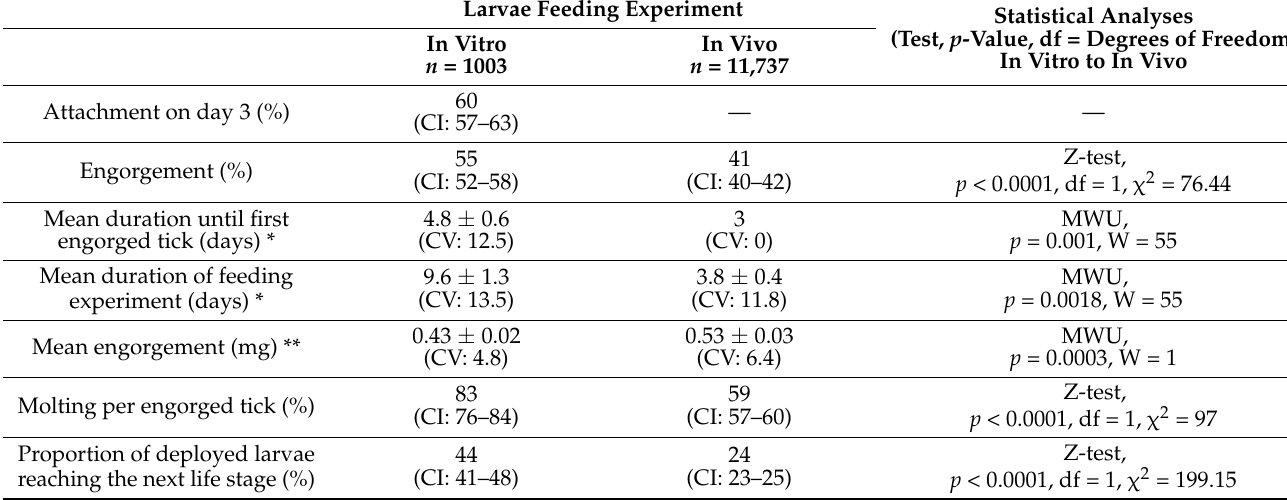
Figure 2. Mean proportions (%) per feeding unit for ( a ) larvae, ( b ) nymphs and ( c ) F 0 adults and ( d ) F 1 adults (with and without vitamin B ) in vitro compared to in vivo (means ± SD). Molting proportion: molted ticks per engorged tick; oviposition proportion: egg batches per detached female; larvae production: viable larvae producing females per egg batch. Table 2. Artificial feeding of I. ricinus larvae.